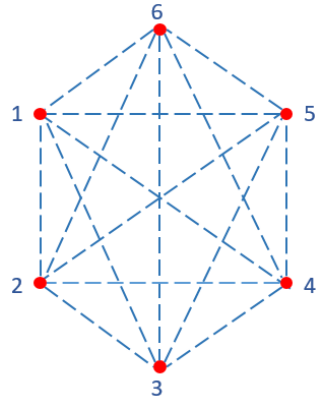
Figure 8. The layout of piezoelectric sensor network.